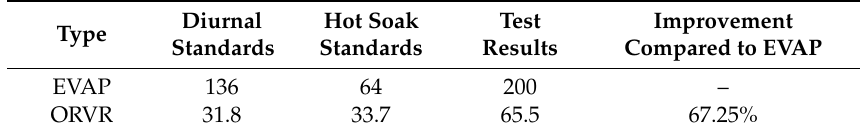
Table 4. Evaporative emission test results of EVAP and ORVR systems